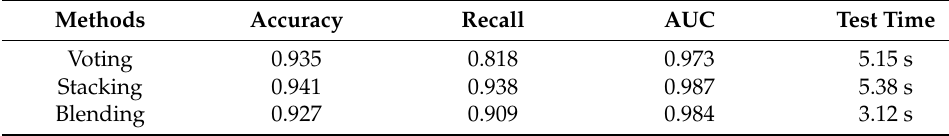
Table 5. Evaluation results of the fusion model